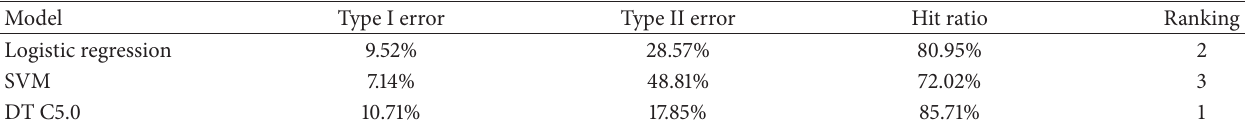
Table 6: Summary of classification results.